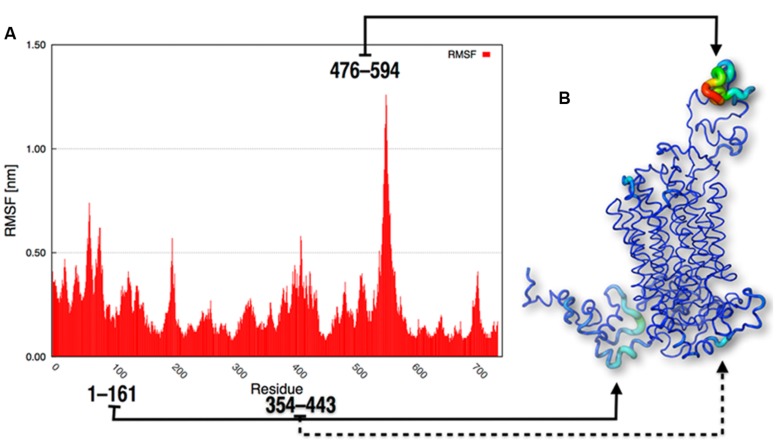
Graphic RMSF representations. (A) RMSF of the atomic positions and (B) representation of protein flexibility as a gradient from low to high fluctuations.